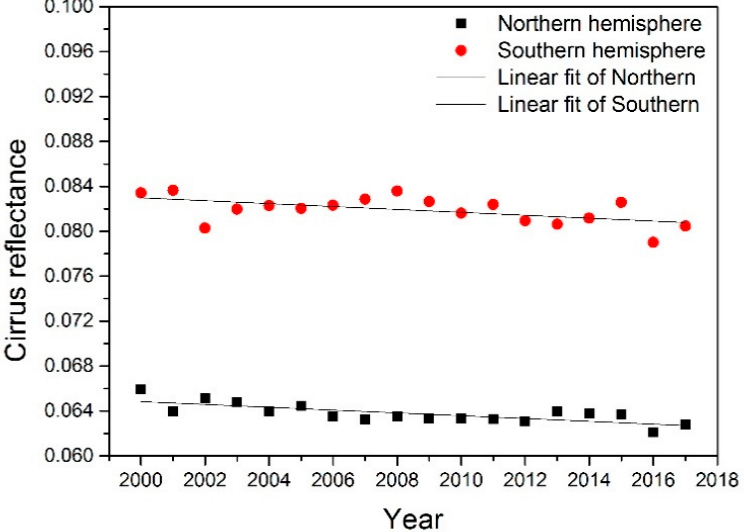
Figure 5. The hemispheric cirrus reflectance vs. year.